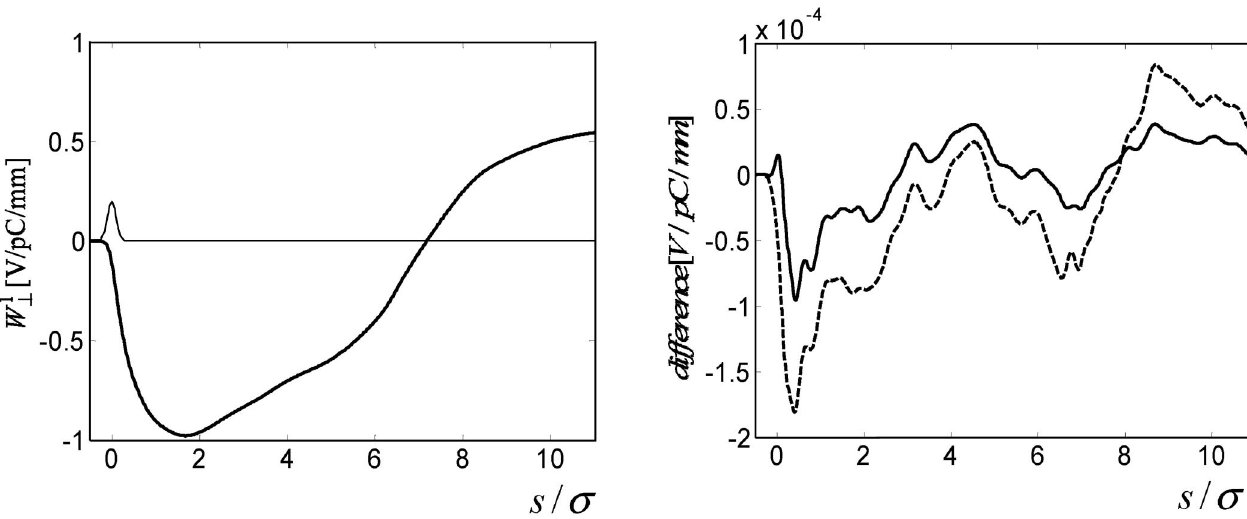
FIG. 7. The left-hand figure shows the transverse wake potential for the TESLA cryomodule excited by a Gaussian bunch with a rms width 9 (cid:5) 1 mm as obtained from the reference code [16]. In the right-hand figure the solid line shows the difference between the reference potential and the one obtained with the help of the TE/TM(1) scheme, and the dashed line shows likewise the result for the TE/TM-ADI2(1)